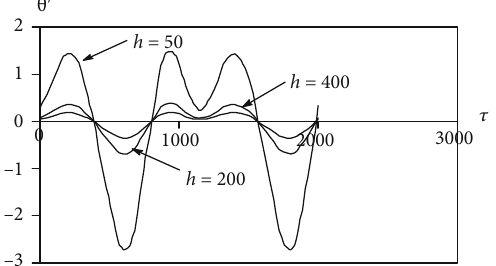
Figure 5: The analytical and numerical angular velocities θ ′ against τ at h = 400 , 200, and 50.